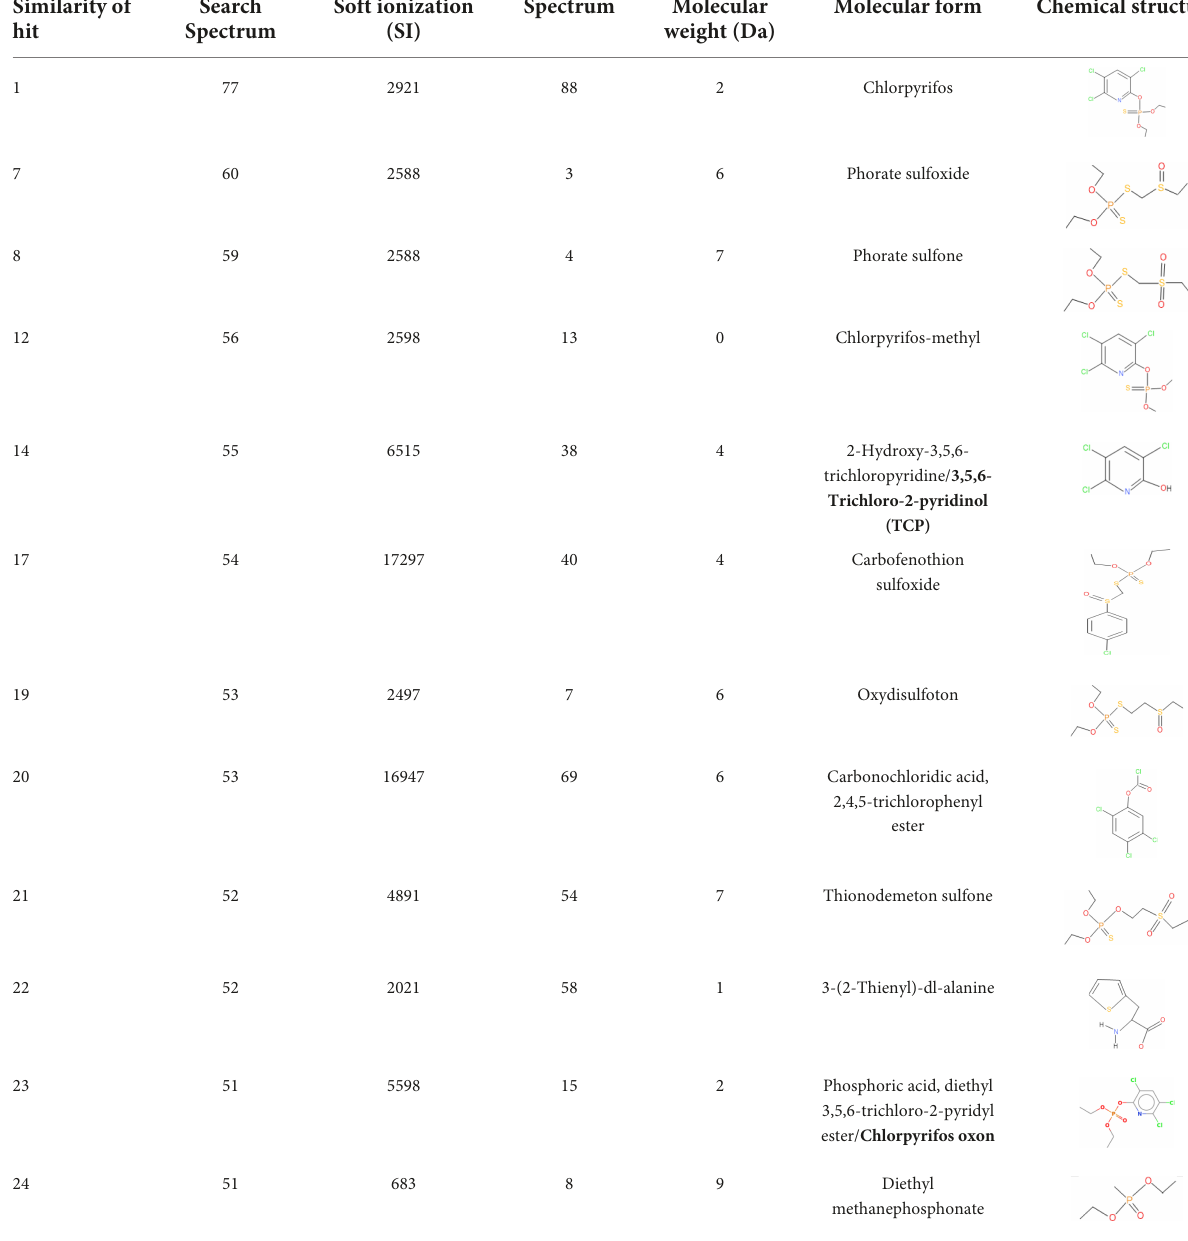
TABLE 3 Spectrum, molecular form and chemical structure of chlorpyrifos (1 gm/100 mL) biodegradation observed using GC–MS/MS analysis. Similarity of